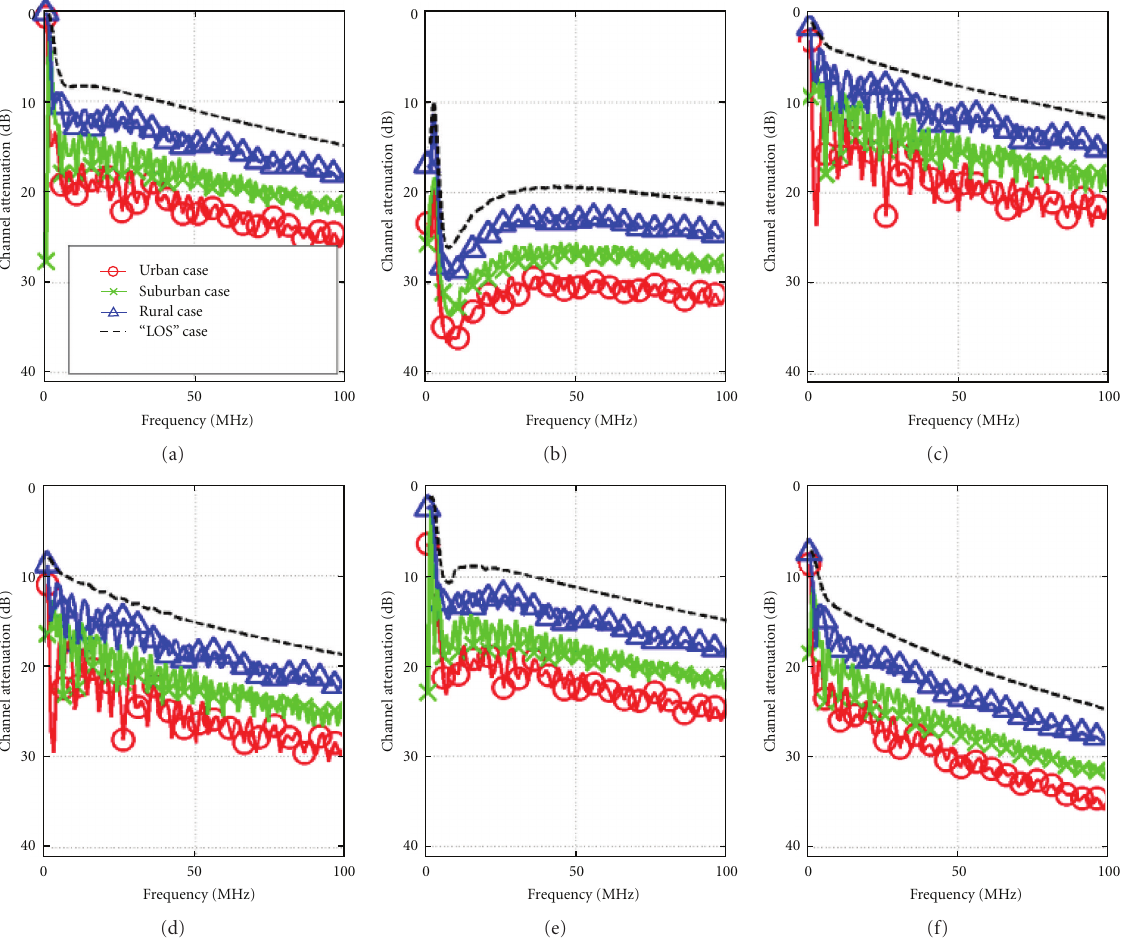
Figure 5: End-to-end channel attenuation versus frequency for urban case, suburban case, rural case, and “LOS” transmission case when open circuit branch terminations are assumed (for plot clarity reasons, the subchannel frequency spacing is equal to 1MHz). (a, b) Modal— DM 4 —and coupling scheme—WtW 1 − 2 —analysis of 150 kV single-circuit, respectively. (c, d) Modal—DM 4 —and coupling scheme— WtW 1 − 2 —analysis of 275 kV double-circuit, respectively. (e, f) Modal—DM 4 —and coupling scheme—WtW 1 − 2 —analysis of 400kV double- circuit, respectively. Table 1: Average end-to-end channel attenuation for various overhead HV/BPL configurations and topologies. Average end-to-end channel attenuation (dB)